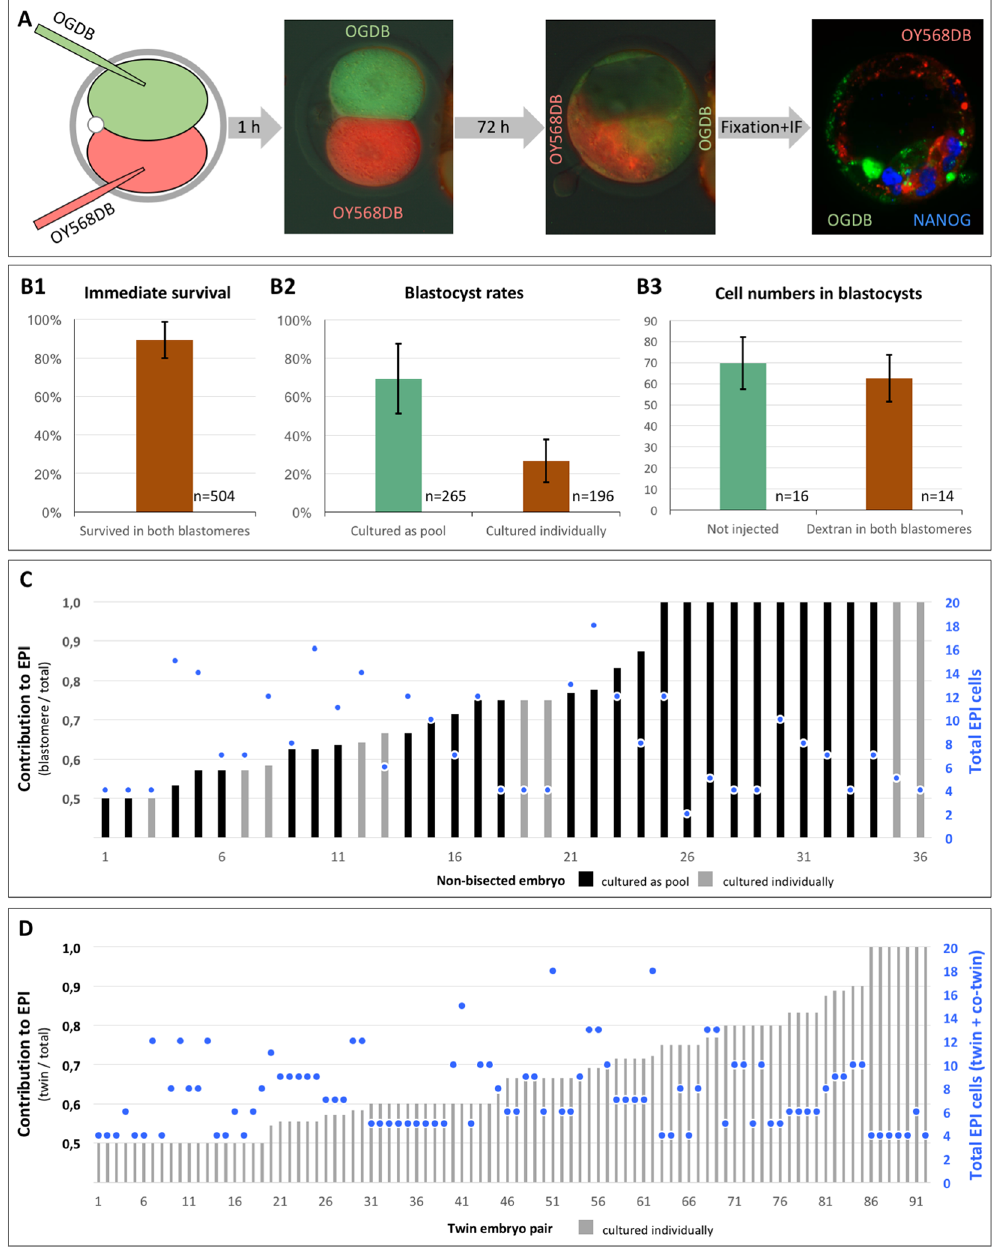
Figure 4. Tracing of the contribution of sister two-cell stage blastomeres to epiblast. Each blastomere in two-cell embryos were microinjected with fluorescent dextran beads of different colors (OGDB, OY568DB), followed by in vitro culture to blastocyst and NANOG immunofluorescence analysis ( A ). The quality of the microinjections was validated by survival rates of the blastomeres, blastocyst rates, and total cell numbers of blastocysts ( B ). The relative contribution of each two-cell blastomere to EPI (ratio from 0.5 to 1) and the absolute total number of EPI cells ( • ) are shown for non-bisected ( C ) and twin ( D ) embryos. Error bars in ( B ) are standard deviations. Black and gray bars in ( C ) and ( D ) indicate embryos cultured as pools and embryos cultured individually,